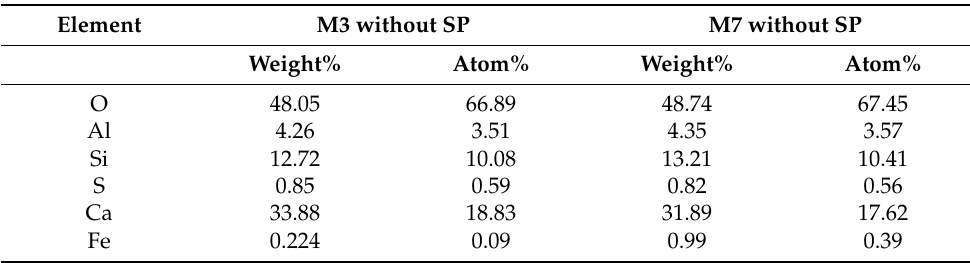
Figure 11. ( A , B ) EDX output of setting time samples of blended mixes M3 and M7 without superplasticiser; ( C , D ) EDX output of setting time samples of blended mixes M3 and M7 with superplasticiser. Table 3. The element compositions for the setting time samples of. blended mixes M3 and M7 without superplasticiser.